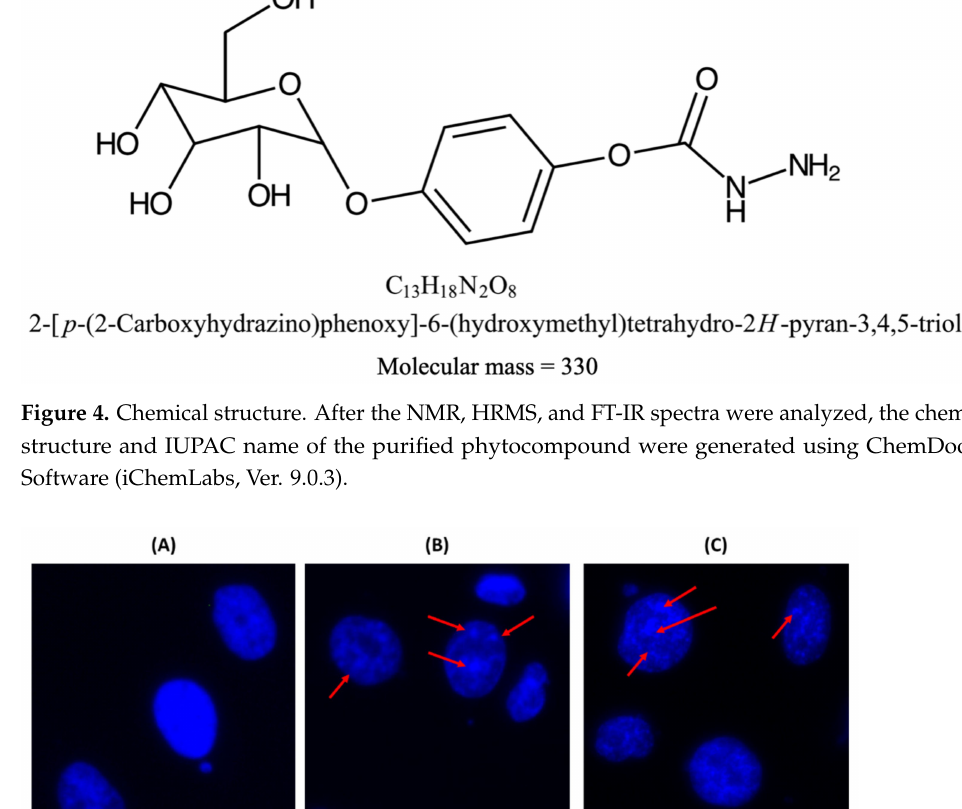
Figure 5. Oroxyquinone-induced chromatin nucleation: PC3 cells treated with PBS ( A ), 30 µ M ( B ) and 60 µ M ( C ) of oroxyquinone were stained with DAPI and observed under a fluorescent microscope. Nucleation, indicated by red arrows, was observed in cells treated with the purified compound.